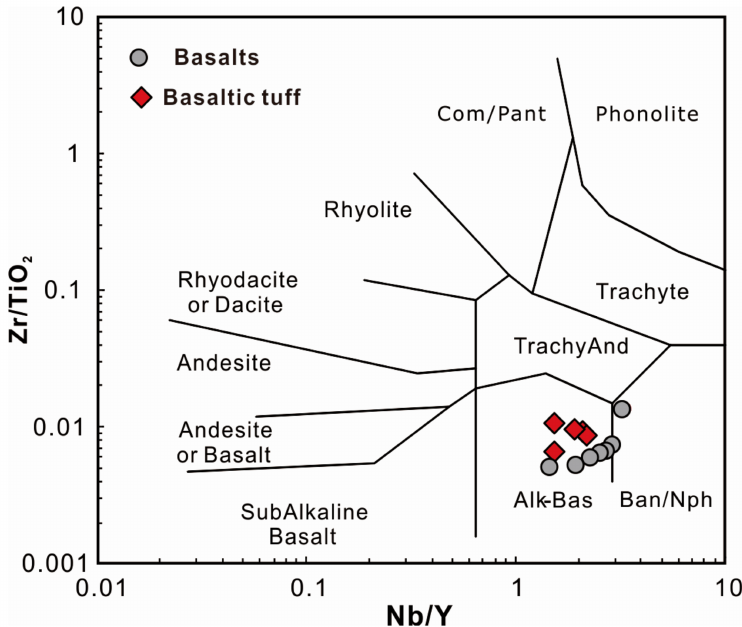
Figure 8. Bulk-rock compositions of the Laochang volcanic rocks in a Zr/Ti versus Nb/Y.